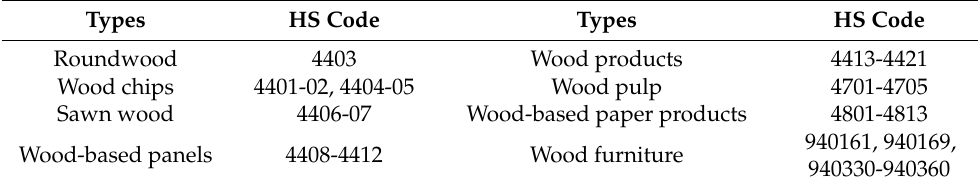
Table 2. The forest product types and their customs HS92